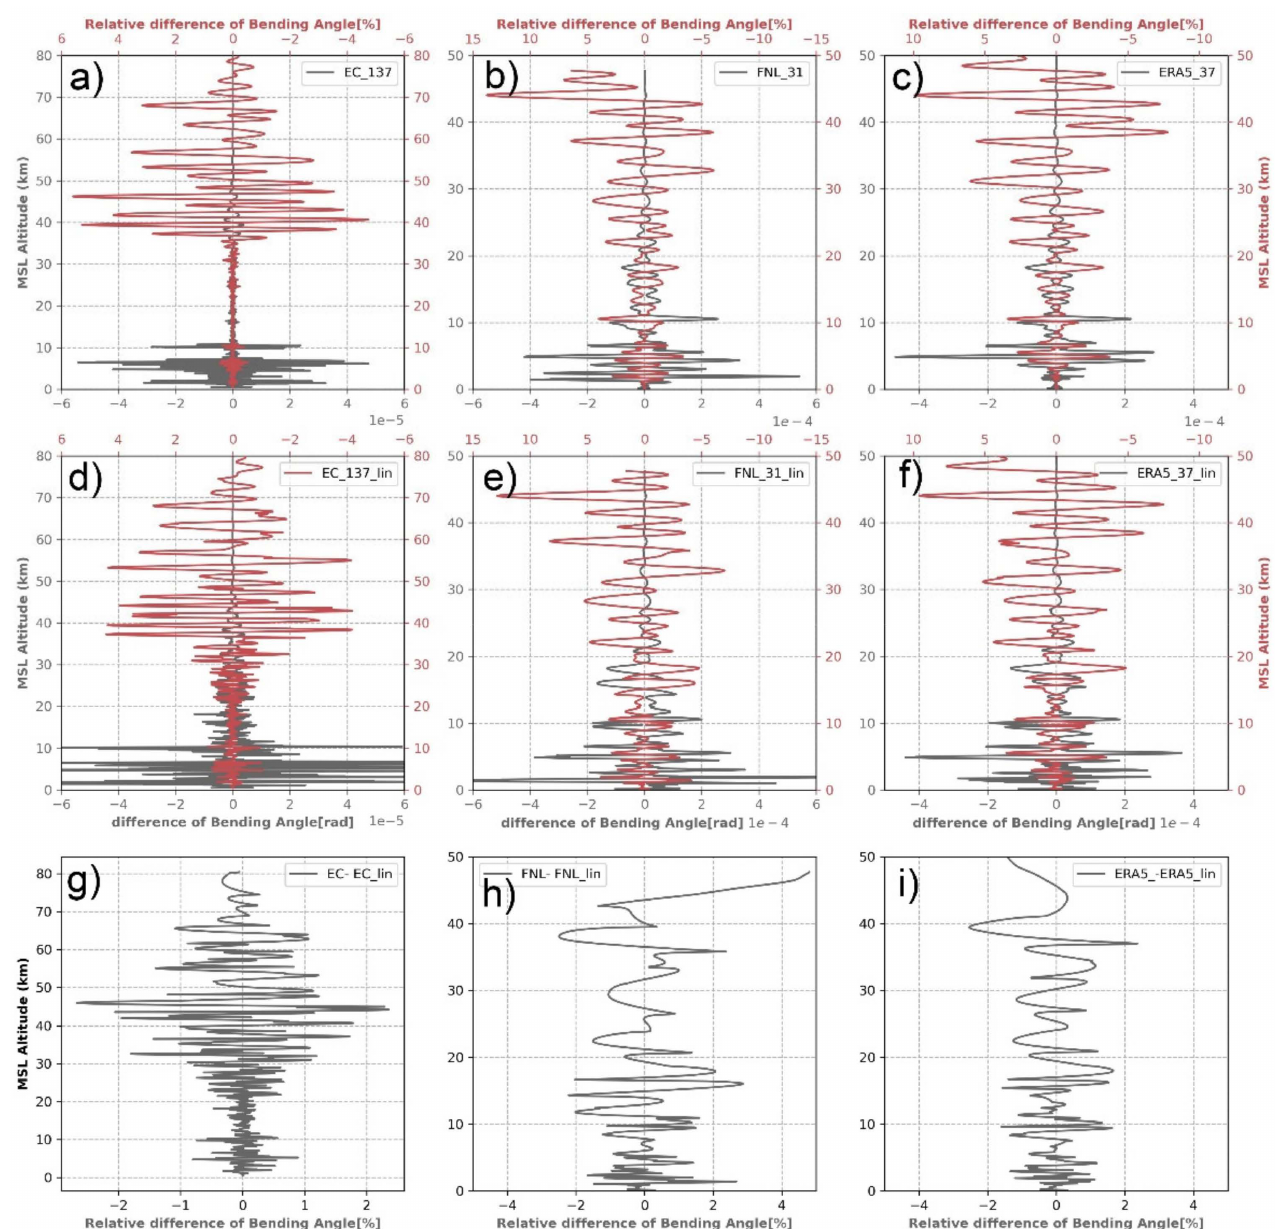
Figure 8. BA difference (E − T, in gray) and RD (E − T ) /T, in red) for EC4Dvar, FNL, ERA5, and FY3D based on the exp algorithm and log-cubic interpolation ( a – c ) and log-linear interpolation ( d – f ). ( g – i ) The difference between the RD of log-cubic interpolation and that of log-linear